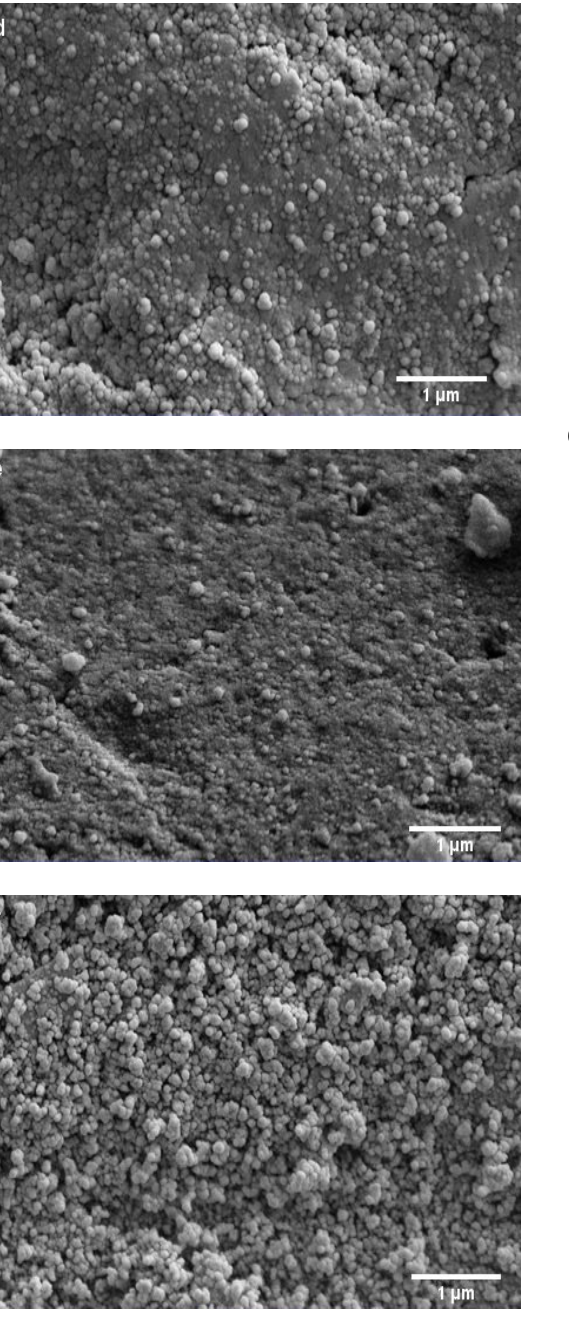
Figure 3. SEM images and size distribution of ( a ) MNP, ( b ) SiMNP, ( c ) A-MNP, ( d ) RMNP, ( e ) A-SiMNP, and ( f ) A-RMNP.